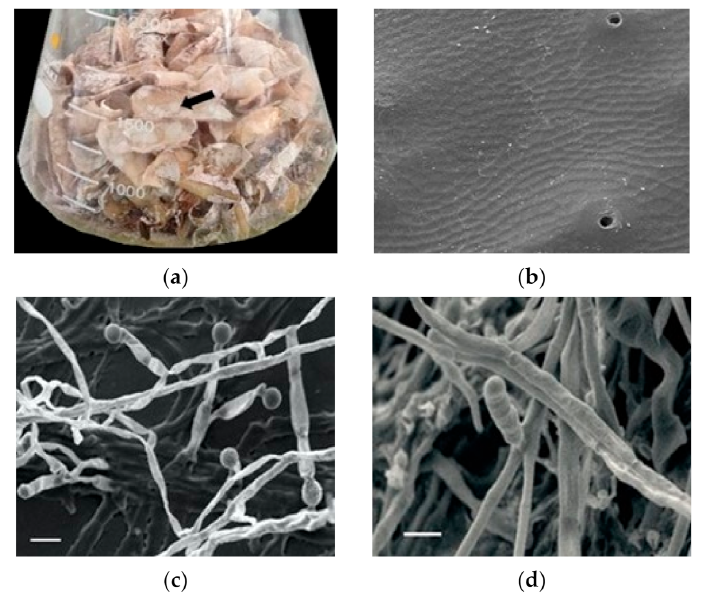
Figure 5. SEM image ( a ) solid state fermentation 18A13O1 in shrimp shell media, ( b ) surface shrimp shell, ( c ) actinomycetes 18A13O1 on solid shrimp shell media after 7 days bar 20 µιχρ o ν , and ( d ) after 21 days 20 micron.